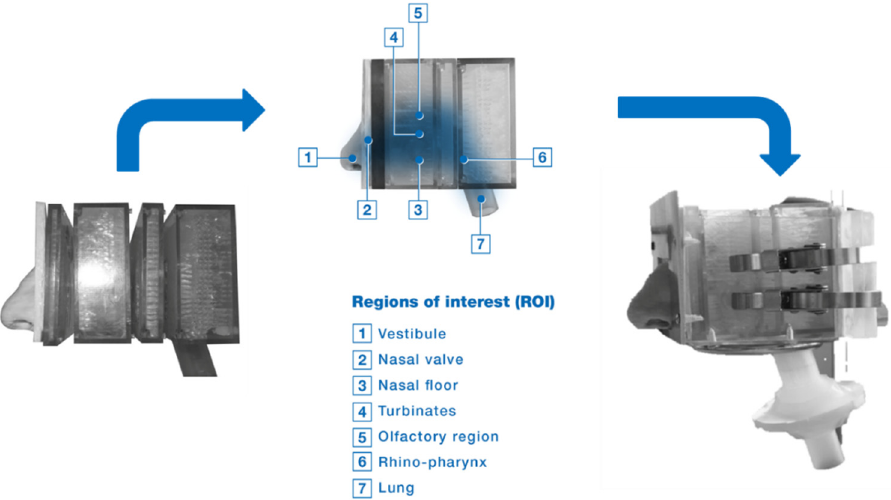
Figure 4. Example in vitro cast (APTAR/DTF/Univ. of Tours) and representative sections. The nasal cast is derived from adult male computed tomography (CT) scans. The nasal cast is constructed of epoxy plastic and divided into four segments.